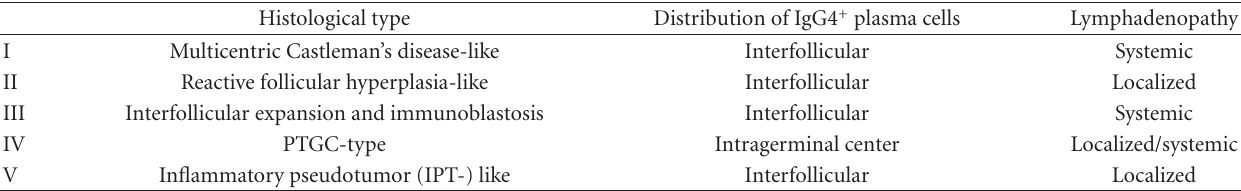
Table 1: Histological subtypes of IgG4-related lymphadenopathy.